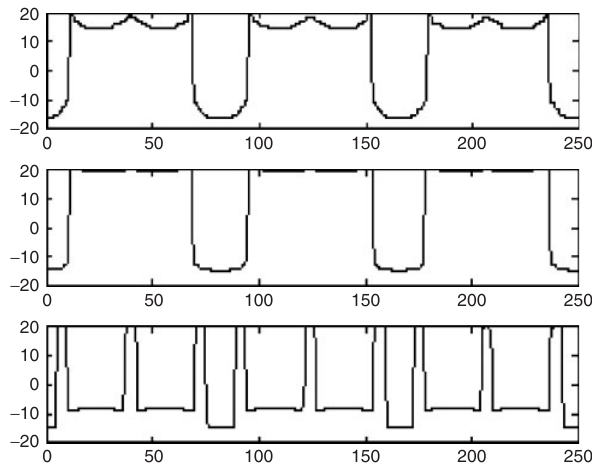
Figure 17 Hard sensor failure without failure detection and